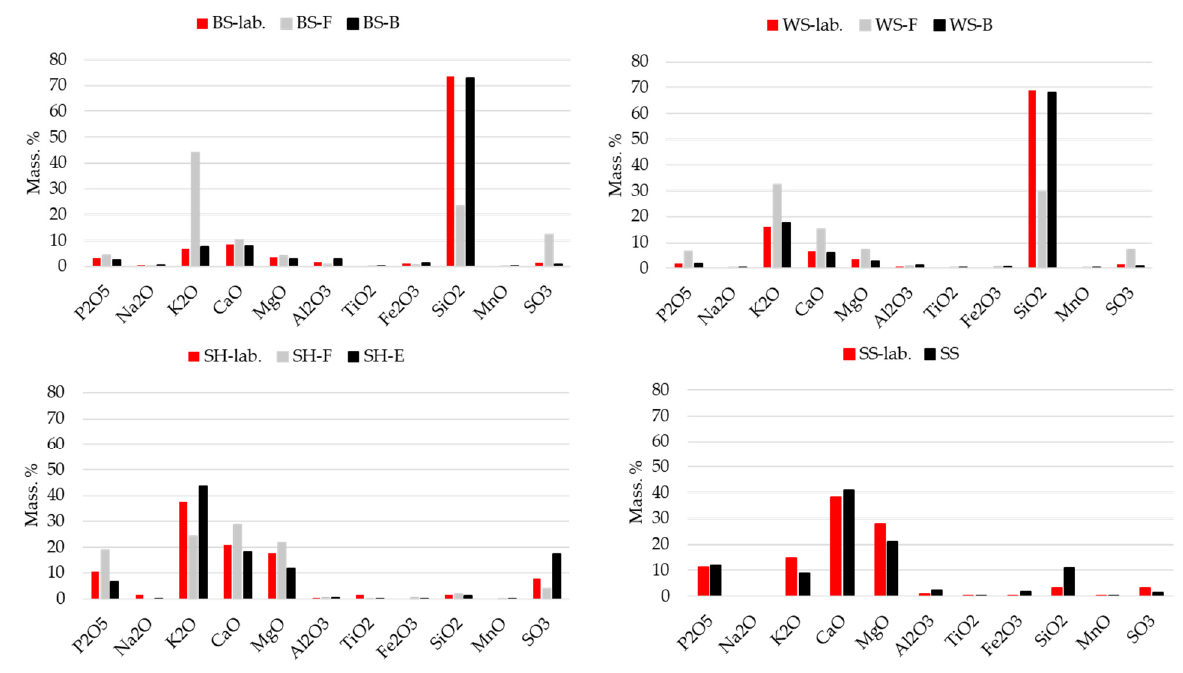
Figure 3. ABA chemical composition.